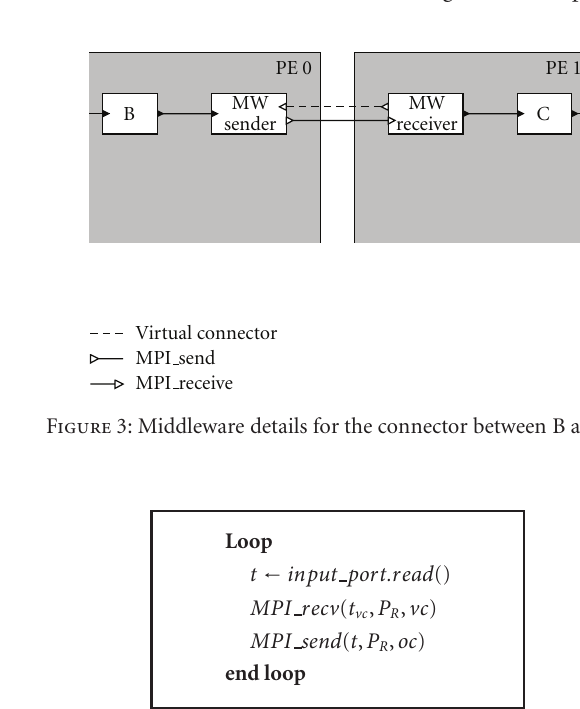
the specific KPN library that is adopted by the application components. Opposedly, a passive middleware layer would and send tokens.